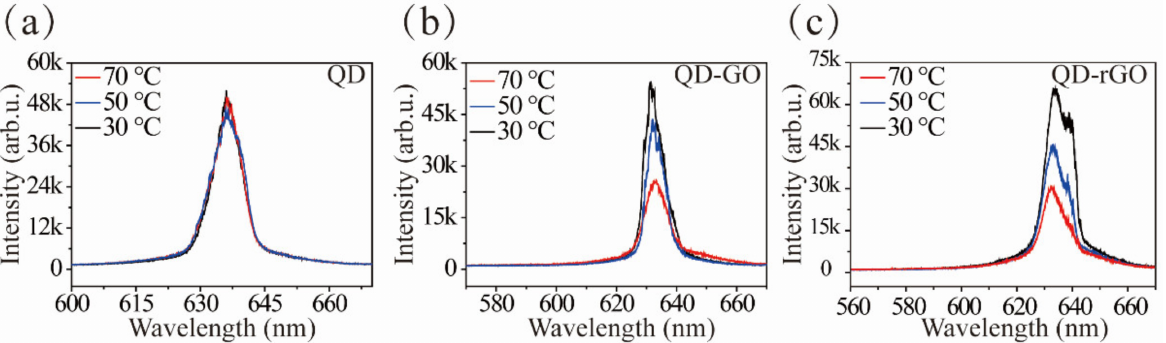
Figure 5. ( a ) The effect of temperature on random laser emission spectra of bare QD, ( b ) QD-GO, and ( c )